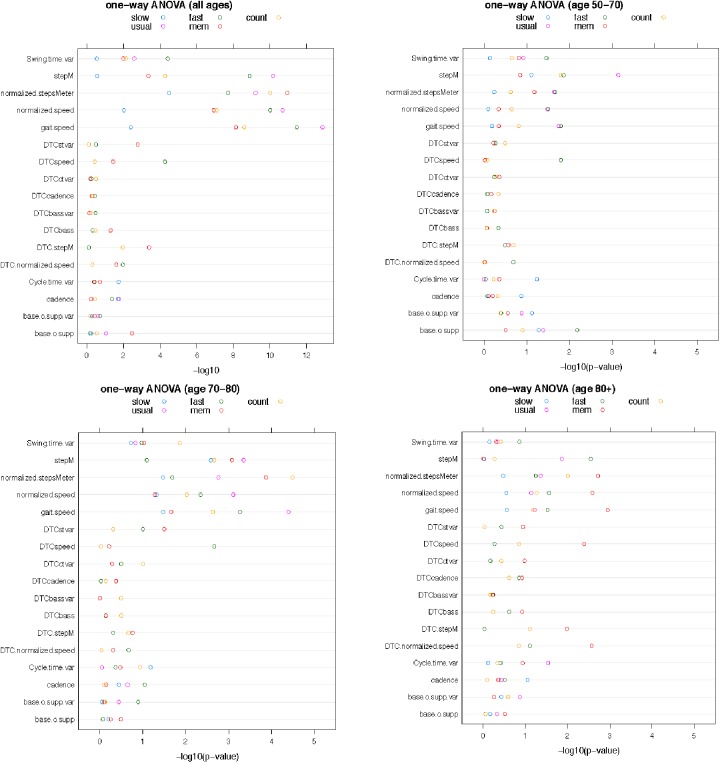
Dotplot: Association between dementia stages (CDR code) and gait variables (one-way ANOVA).Dotplot_all: Association between CDR score and gait (all ages combined). The dotplot shows the negative logarithm (10-based) of the p-values for the one-way ANOVA between gait parameter and CDR score. Strong associations with a small p-value correspond to large values of the–log(p). Each line in the plot corresponds to one gait parameter. On each line, five dots are shown for the 5 walking conditions. Dotplot_5070: Association between CDR score and gait (age 50 to 70). Dotplot_7080: Association between CDR score and gait (age 70–80). Dotplot_80plus: Association between CDR score and gait (above age 80). CDR: Clinical Dementia rating. DTC: dual task cost.